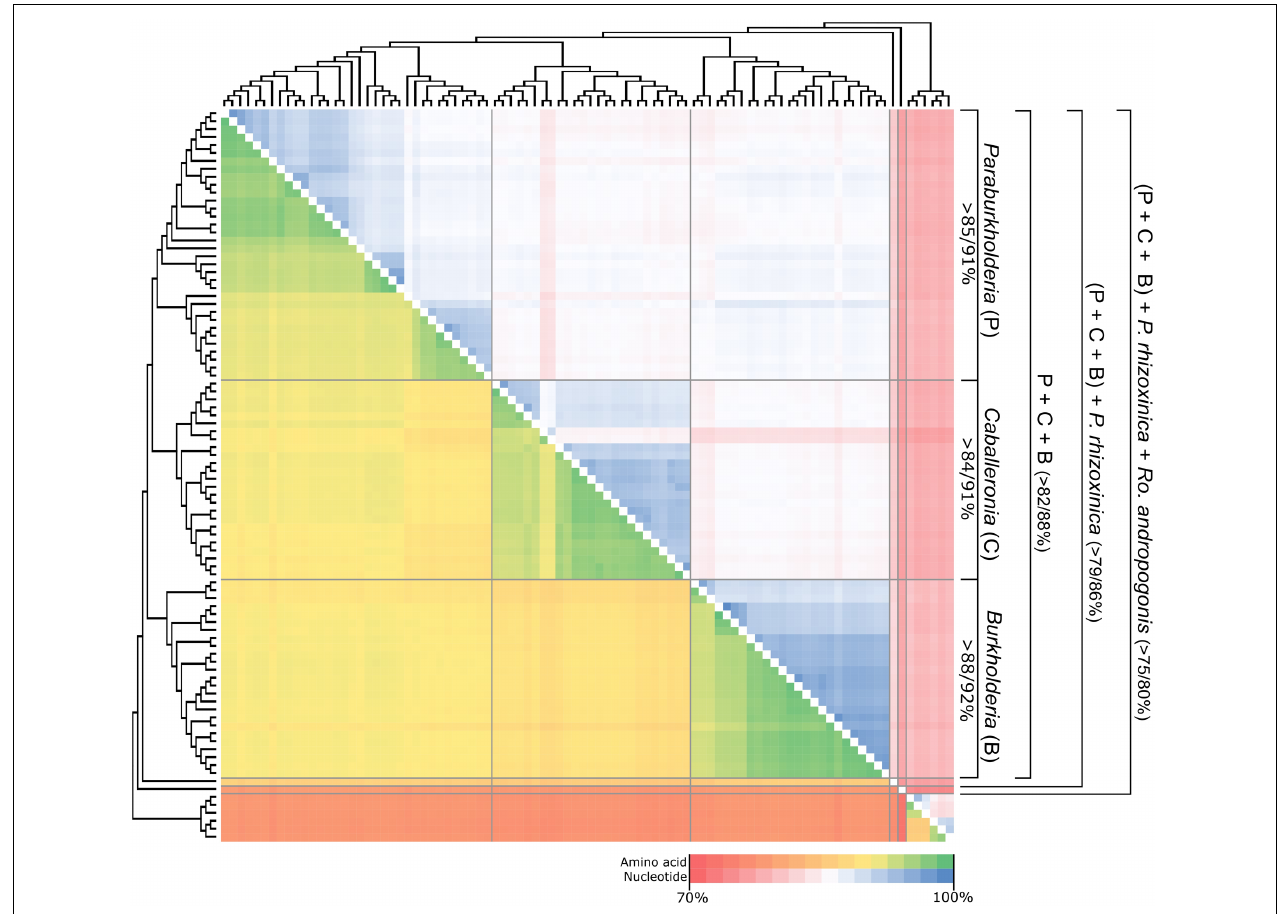
FIGURE 1 | A heat map depicting the sequence similarity of the concatenated sequence of the conserved 106 genes used for phylogenetic analysis. The cladogram indicating the various intra- and intergeneric relationships were inferred from the amino acid based ML topology. Nucleotide similarity values are indicated in the upper triangle of the map, with amino acid similarity values indicated in the lower triangle of the map. A summary of the similarity values for the 5 lineages of interest are indicated for each group (nucleotide/amino acid %), in the panel on the right. For specific values, refer to Supplementary File